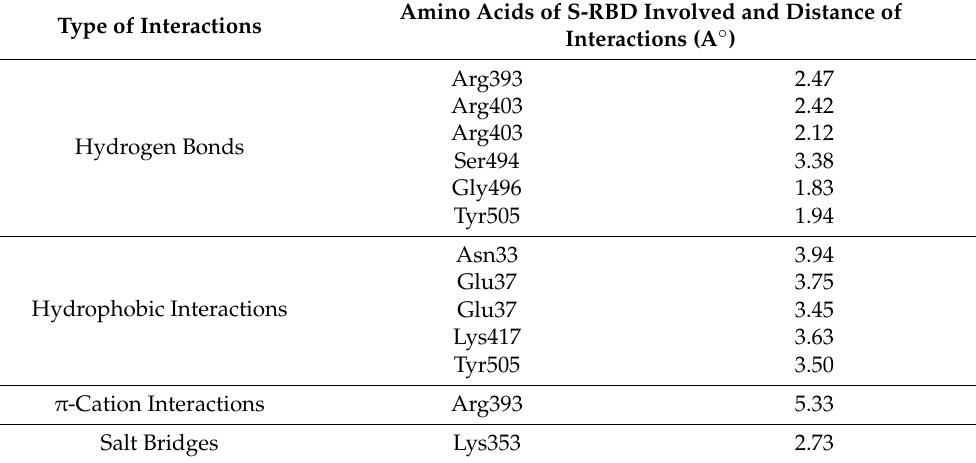
Table 4. Interactions of amino acid residues with EXP3174 at receptor site of RBD of S protein of SARS-CoV-2 using PLIP.